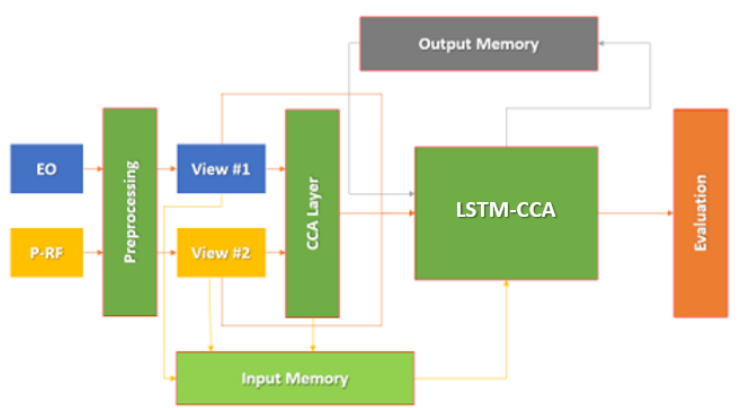
Figure 2. LSTM-CCA architecture